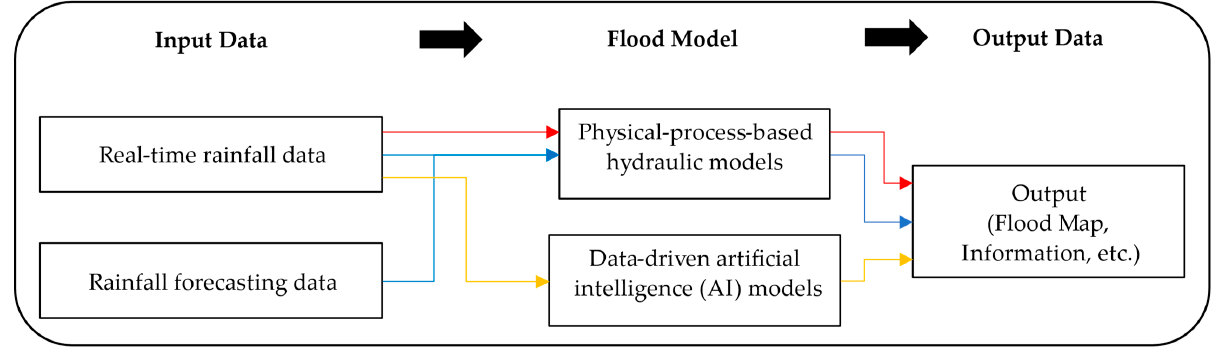
Figure 1. Conceptual diagram of the current real-time urban flood forecasting systems.